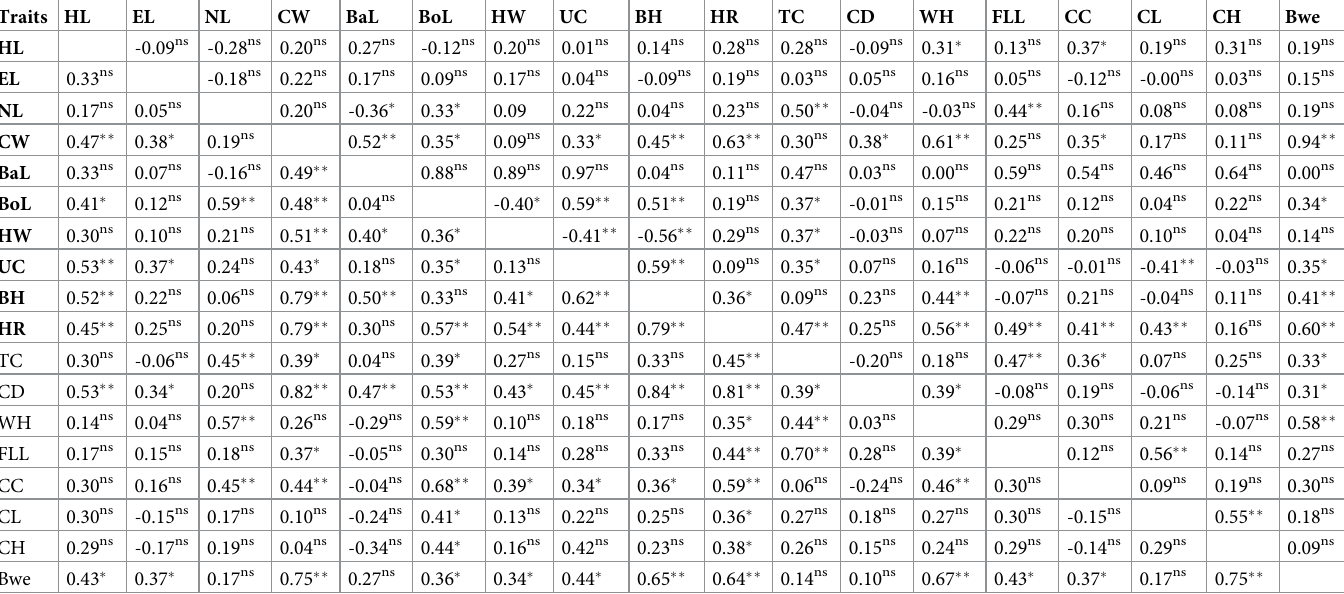
Table 8. Phenotypic correlation between measured traits, male above diagonal and female below diagonal. Traits